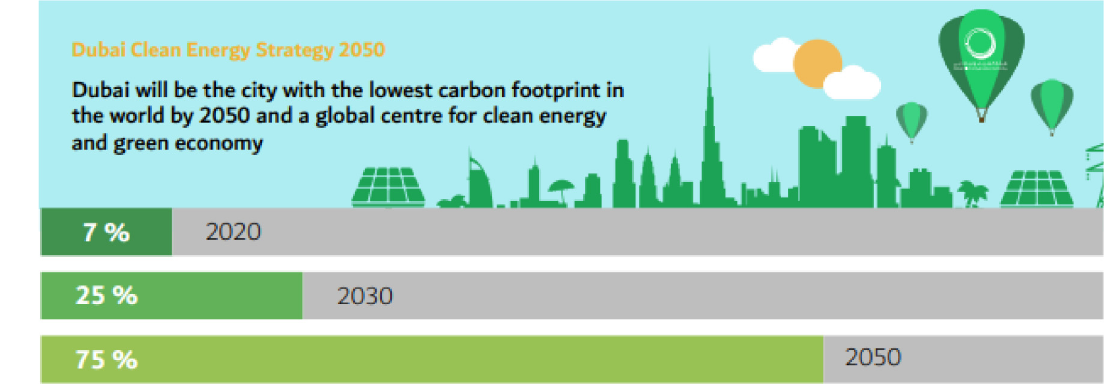
Fig. 4. Moving towards depending on renewable